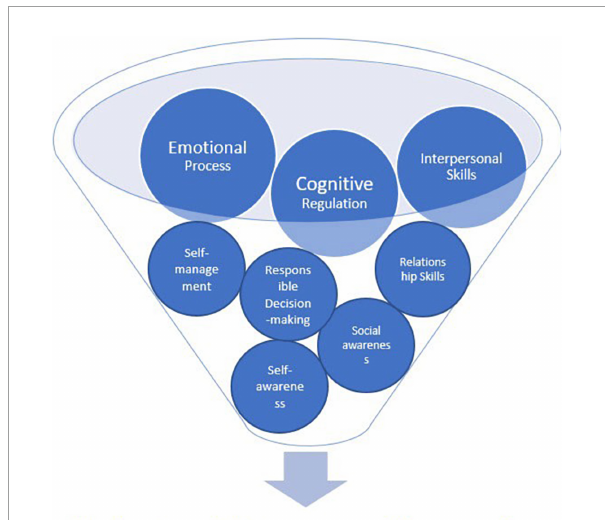
FIGURE1 A multi-level conceptualization of social and emotional learning